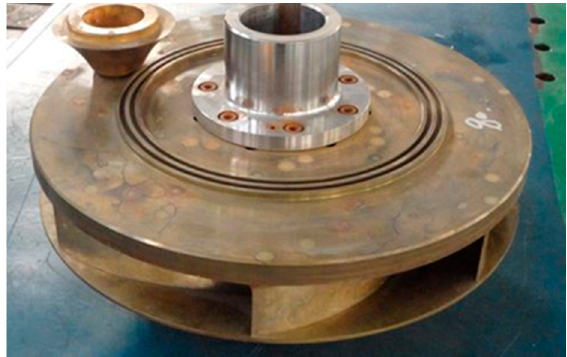
Figure 1. Model runner.